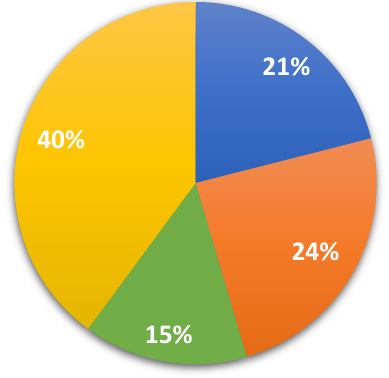
Figure 6. Liability for software changes made by the user. Source: Author’s processing.